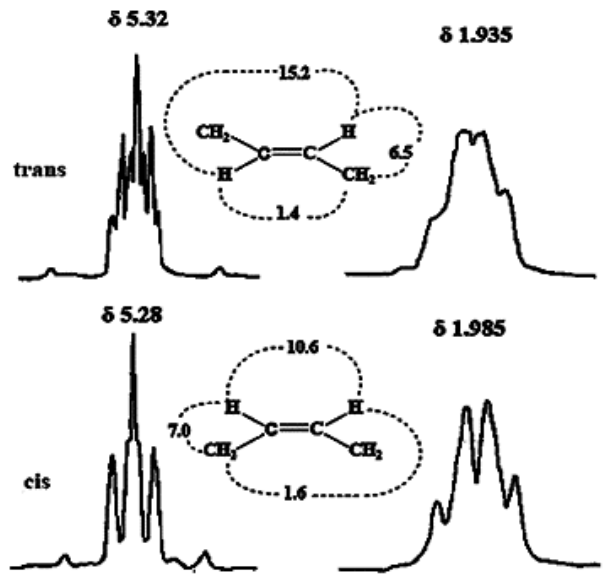
Figure 6. Computer simulated 1 H-NMR signals for alkenyl and allylic protons in isolated cis and trans double bonds. Adopted, with permission, from [54]. Copyright 1975, North-Holland Publishing